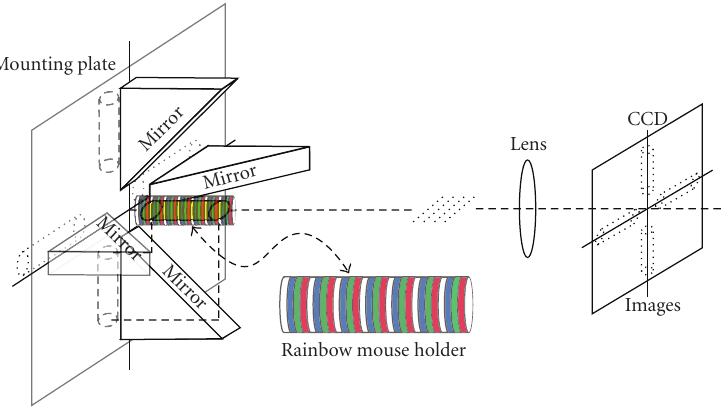
Figure 1: Bioluminescence tomography (BLT) system design for simultaneous acquisition of multiview and multispectral data. This system consists of a multimirror module, a cylindrical/polygonal mouse holder on which rainbow bands are attached for resolving data spectrally, a lens, and a CCD